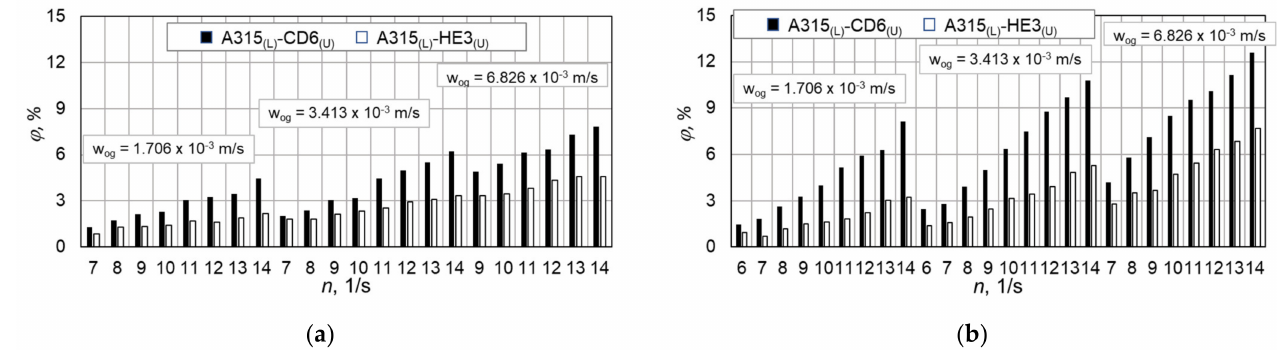
Figure 6. Dependence of ϕ = f( n ) for two different impeller configurations A315 (L) -CD6 (U) or A315 (L) - HE3 (U) and for two different gas–liquid systems: ( a ) air–water system, ( b ) air–aqueous solution NaCl of concentration c = 0.8 kmol/m 3 .